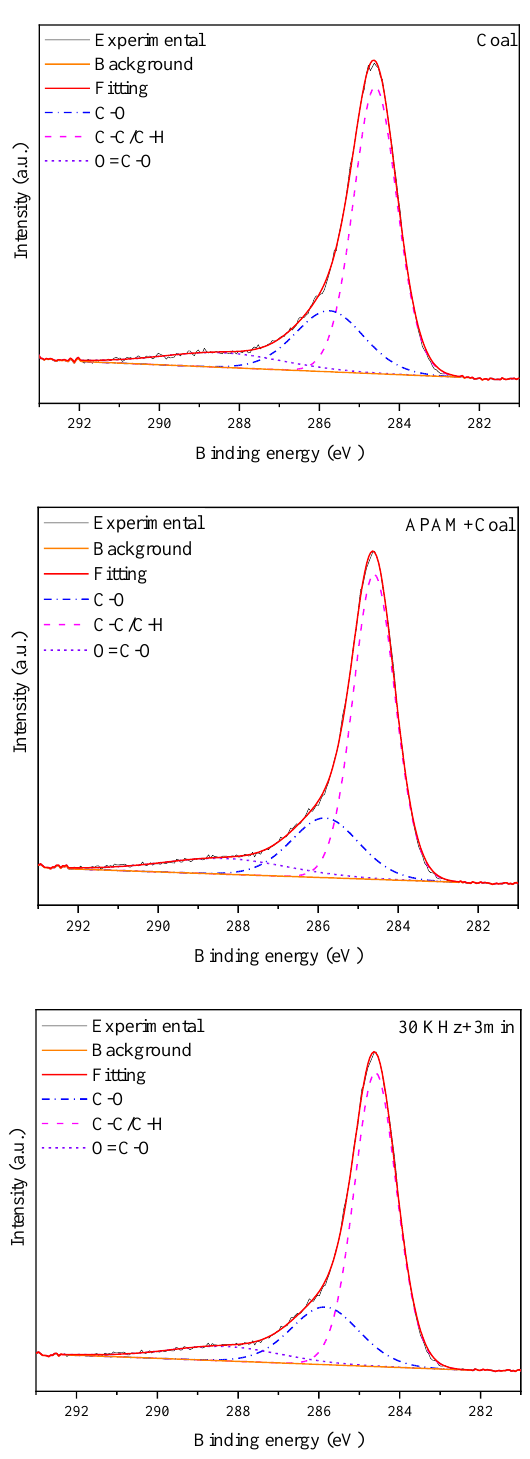
Figure 11. C 1s XPS spectra of LRC slurry under different conditions. Table 3. Content of groups on the slurry surface under different conditions.